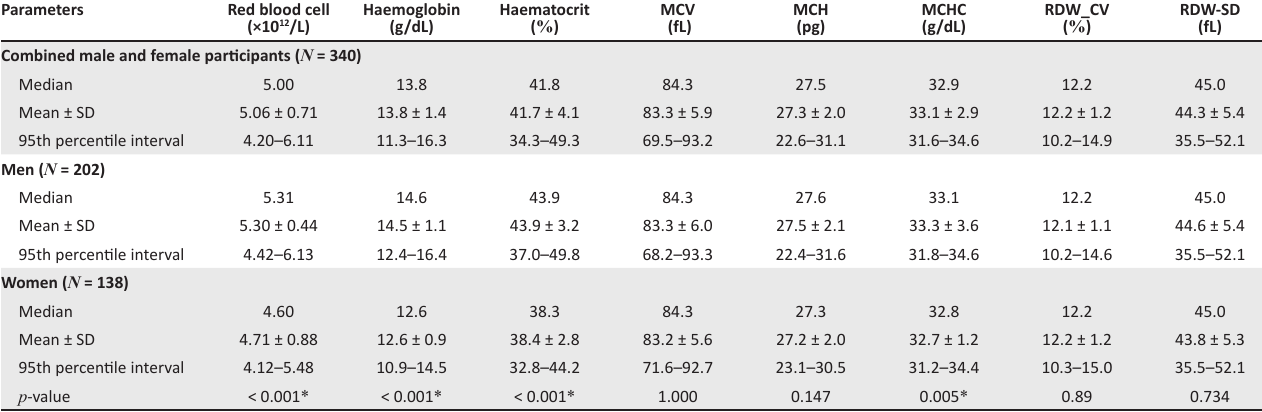
TABLE 2: Erythrocyte parameter reference intervals of healthy adults stratified by sex, Bamenda, Cameroon, April-September 2015. Parameters